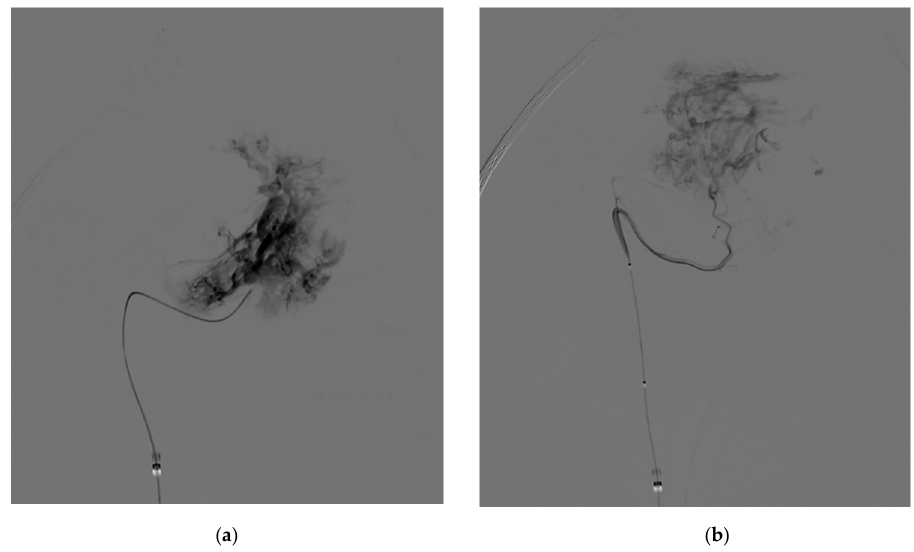
Figure 3. Intraprocedural DSA: PA view of superselective injection of distal IMA ( a ) and APhA ( b ) feeders.